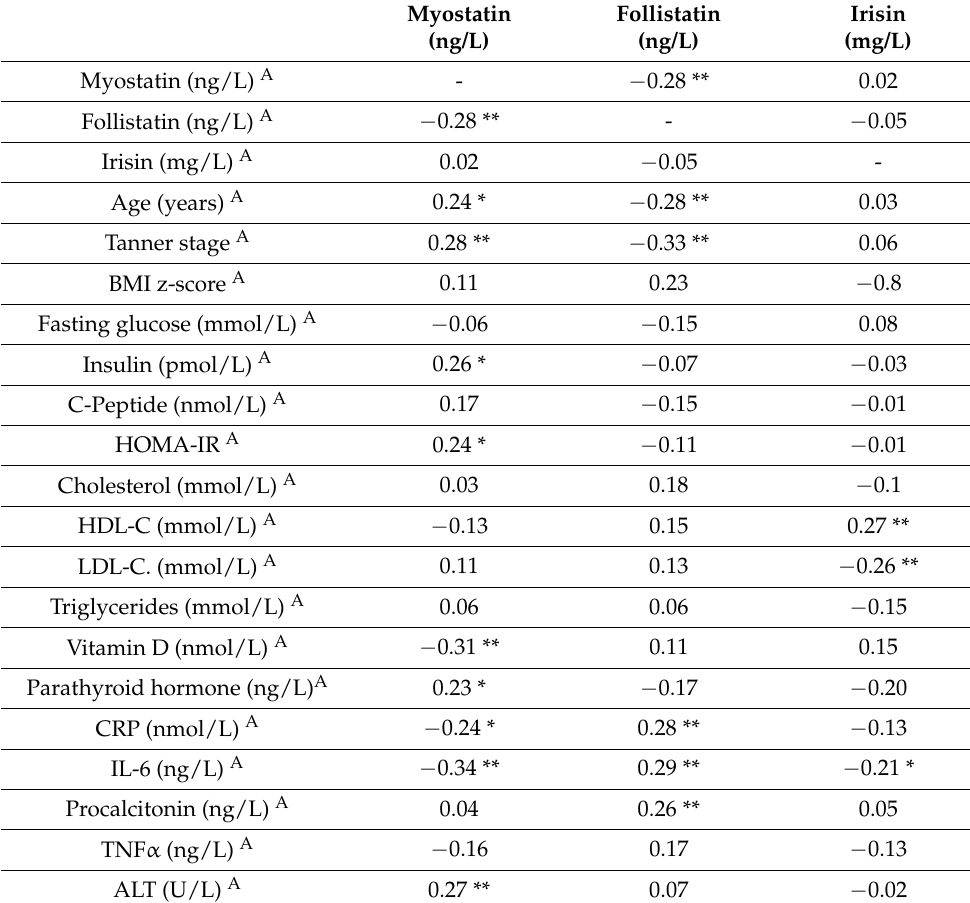
Table 2 gives the correlation coefficients of myostatin, follistatin and irisin with var- ious parameters. As expected, myostatin concentrations negatively correlated with fol- listatin, while there was no association with irisin. Myostatin positively and follistatin negatively correlated with age and pubertal (Tanner) stage, but none of the investigated myokines/hepatokines correlated with the BMI within this group with severe obesity. Table 2. Correlation of myostatin, follistatin and